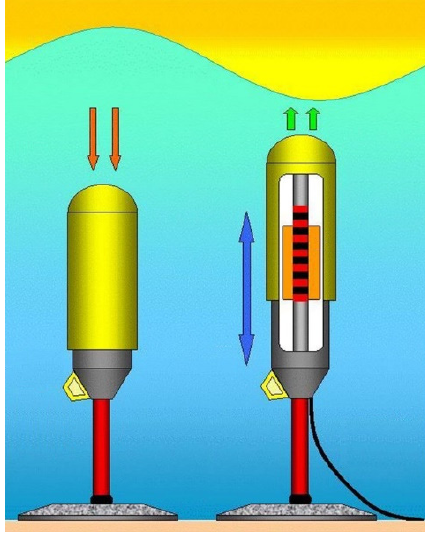
Figure 21. Working principle of Archimedes Wave Swing [76].